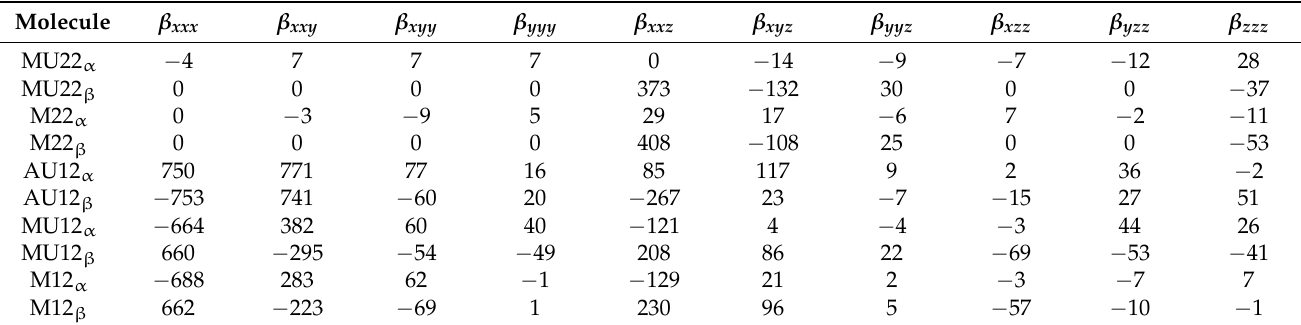
Differences are also visible in the hyperpolarizability tensor components which con- tribute to the non-linear response in different directions (Table 6). Here as well, inducing bulk alignment of molecules may provide means of maximizing the material’s response. Table 6. Components of the hyperpolarizability tensor for the selected conformations of the studied molecules. The values are given in atomic units (1 a.u. = 3.206 × 10 − 53 C 3 · m 3 · J − 2